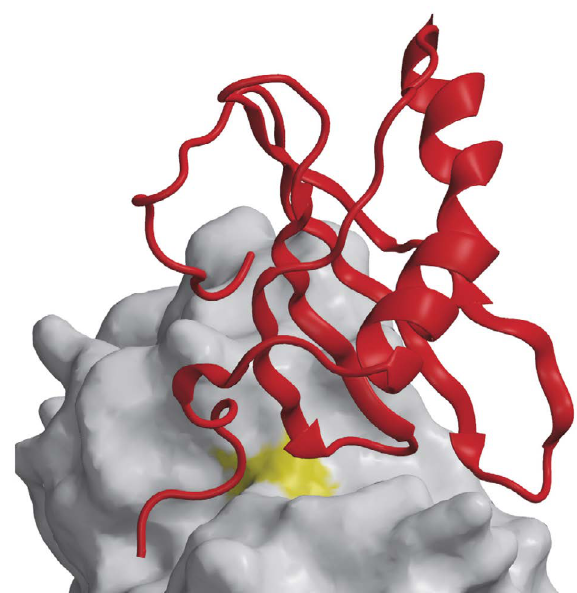
Figure 2. Papain – stefin B complex 127 (1STF). Stefin B fold is shown in red bound to papain shown as white surface with catalytic Cys area in yellow. All images (Figure 2–6) were made with MAIN soft- ware. 130